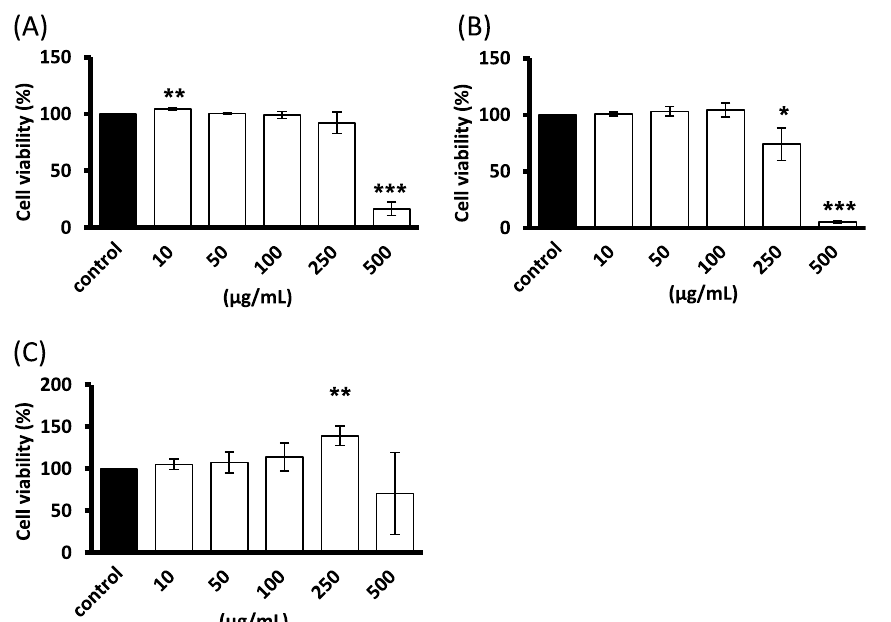
Fig. 2 Cell viability in dermatological cells treated with of B. formosana callus extract. A Hs68 fibroblast cells. B HaCaT keratinocytes. C B16F10 melanoma cells. Data are presented as means SD of triplicate experiments. * p < 0.05, ** p < 0.01, and *** p < 0.001 compare with ±